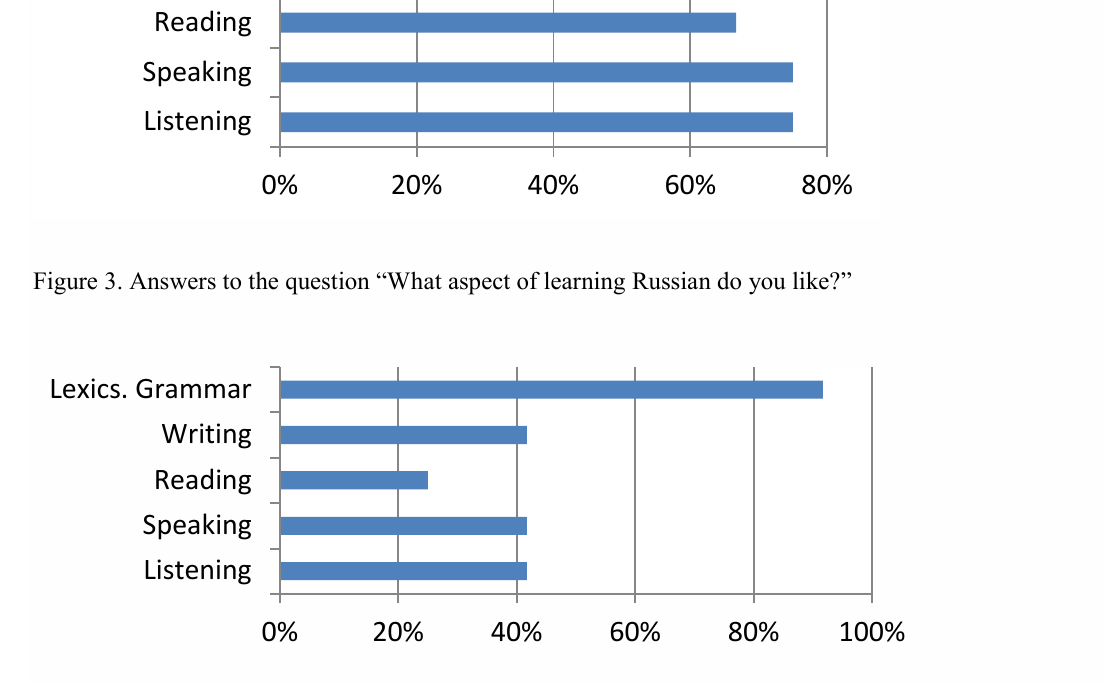
Figure 4. Answers to the question “What aspect is the most difficult for you when learning Russian in a distance format